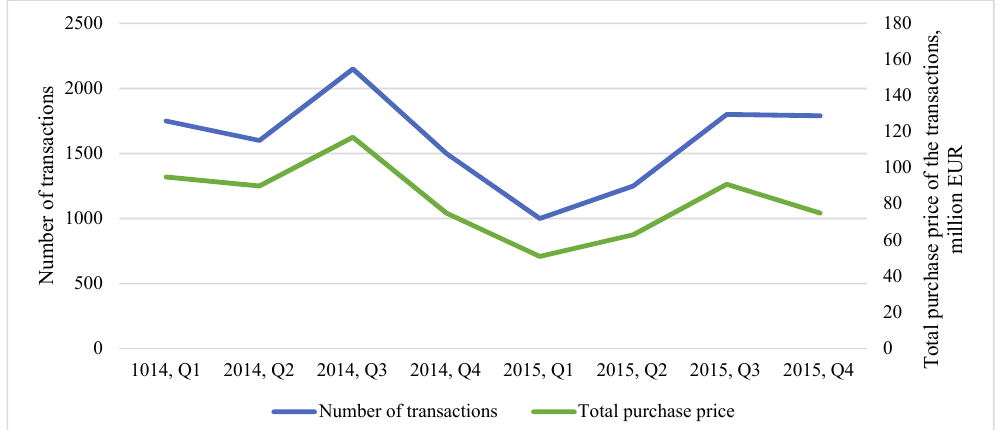
Fig. 5. Dynamics of the total purchase price and the number of transactions with apartments in Riga, 2014–2015 (developed by the authors based on the data from the Land